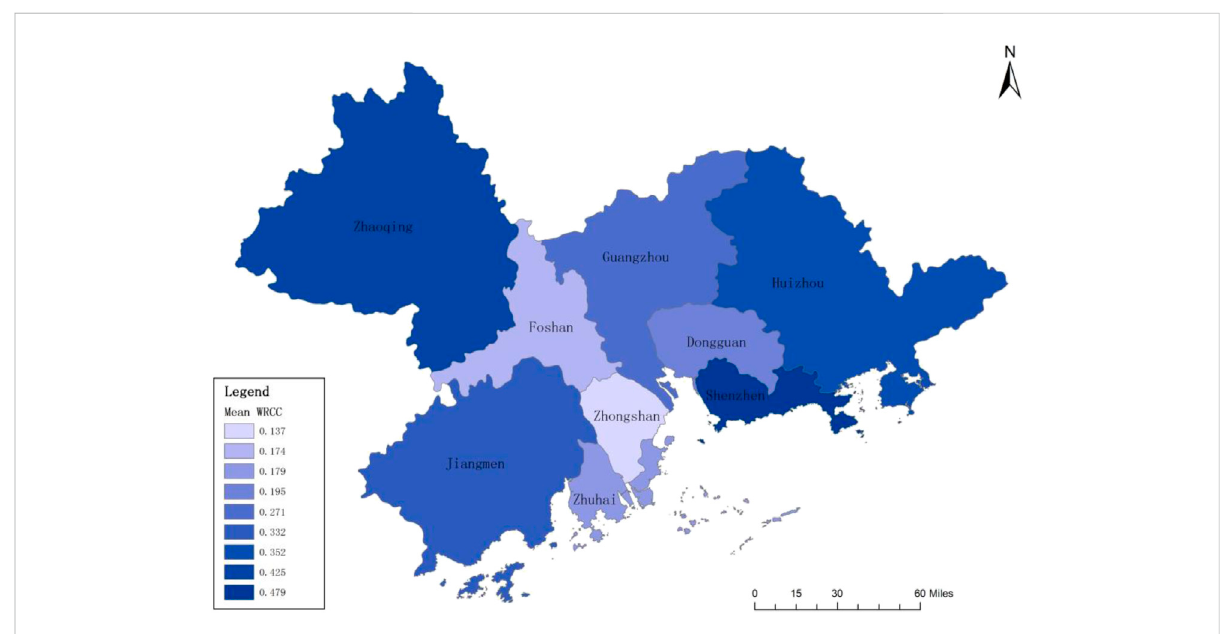
FIGURE 3 Distribution of mean WRCC in PRD in 2015 –